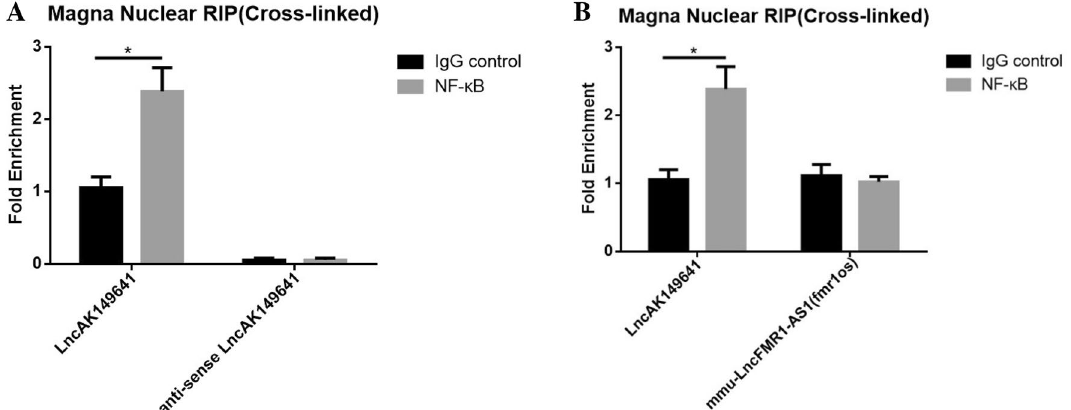
Figure 6. LncRNA-AK149641 bound to NF-κB in the nucleus. Whole-cell lysates were prepared and incubated with either isotype IgG control (isotype) or NF-κB antibodies. Immunoprecipitates were harvested with protein A/G Sepharose beads. RNA was isolated and the lncRNA transcripts in the immunoprecipitates were determined by the qRT-PCR. ( A ) LncRNA-AK149641 and anti-sense lncRNA-AK149641. ( B